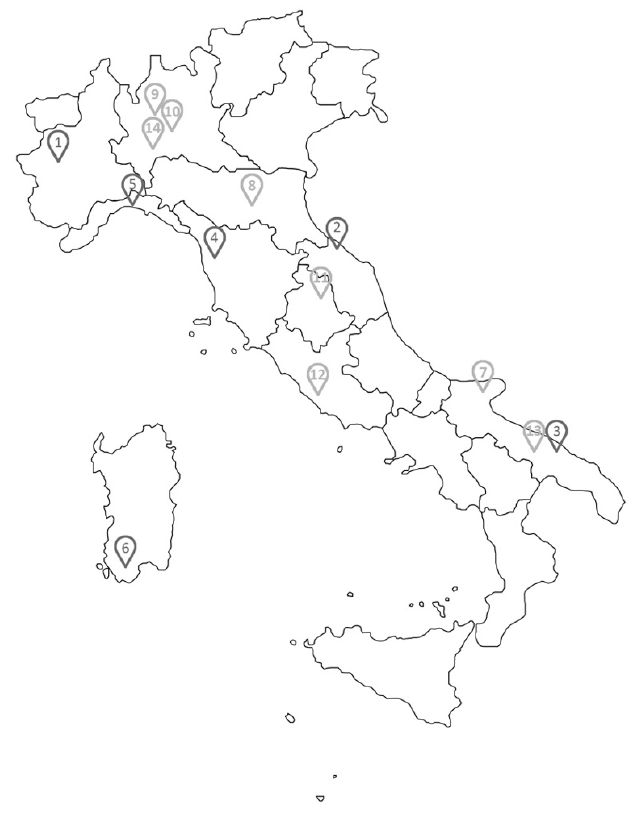
Figure 2. Case studies’ localization.